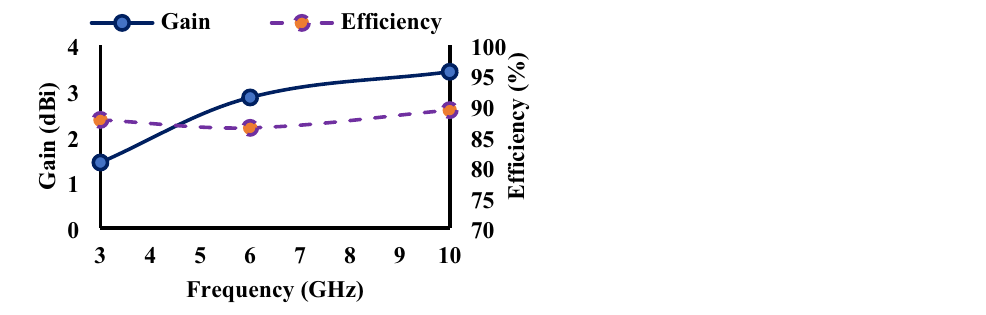
Figure 13. Gain and efficiency of the proposed